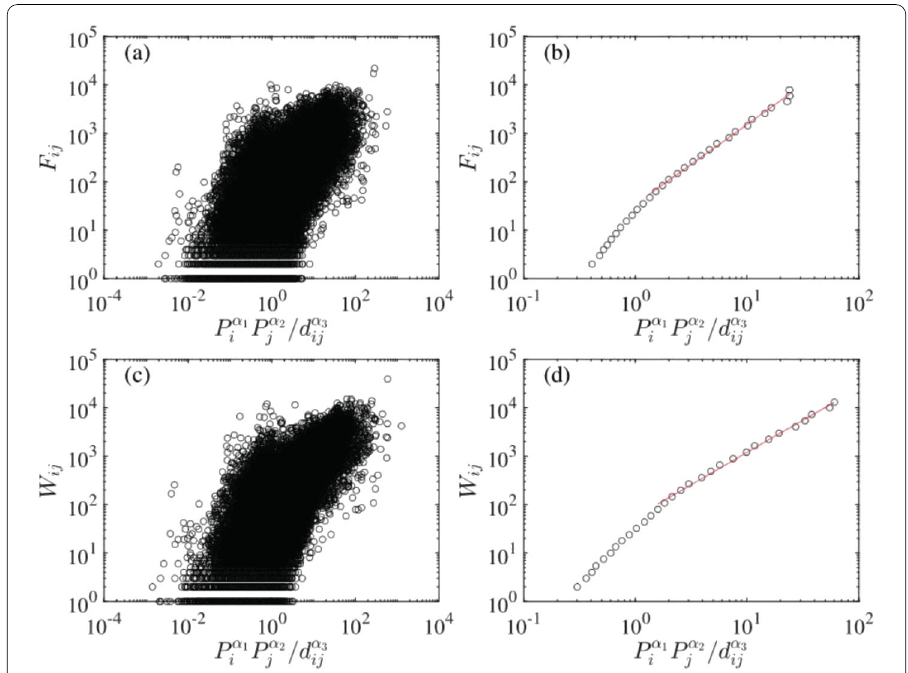
Figure 16 Testing the modified gravity law with population for the directed and undirected freight highway transportation networks constructed over five months. ( a ) Scatter plot of F ij with respect to P α 1 i P α 2 j / d α 3 ij for the directed network. ( b ) Binning plot of F ij with respect to P α 1 plot of W ij with respect to P α 1 i P α 2 j / d α 3 ij for the undirected network. ( d ) Binning plot of W ij with respect to P α 1 i P α 2 j / d α 3 ij for the undirected